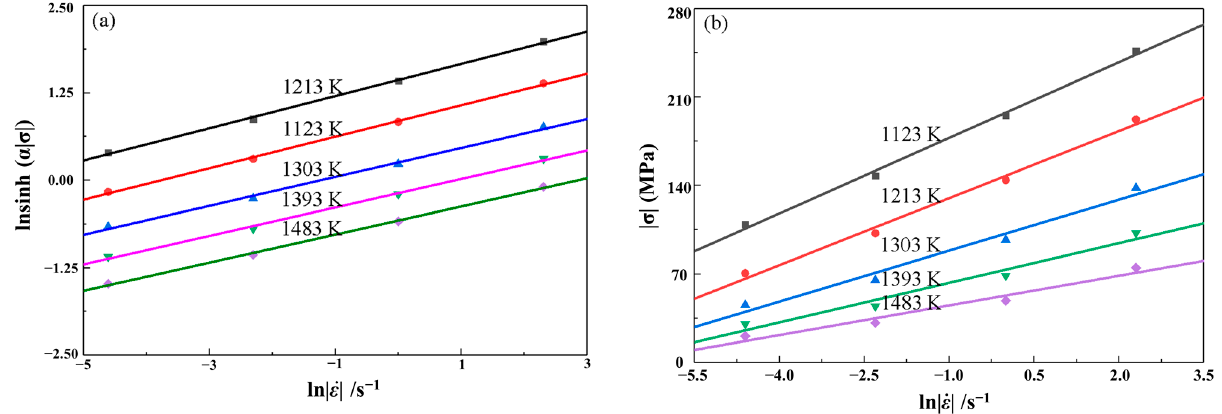
Figure 6. Relationships between strain rates and peak stresses: ( a ) ln|𝜀(cid:4662)| and ln|𝜎| ; ( b ) ln|𝜀(cid:4662)| and |𝜎| . Substituting the hyperbolic law of F ( σ ) into Equation (2) gives,